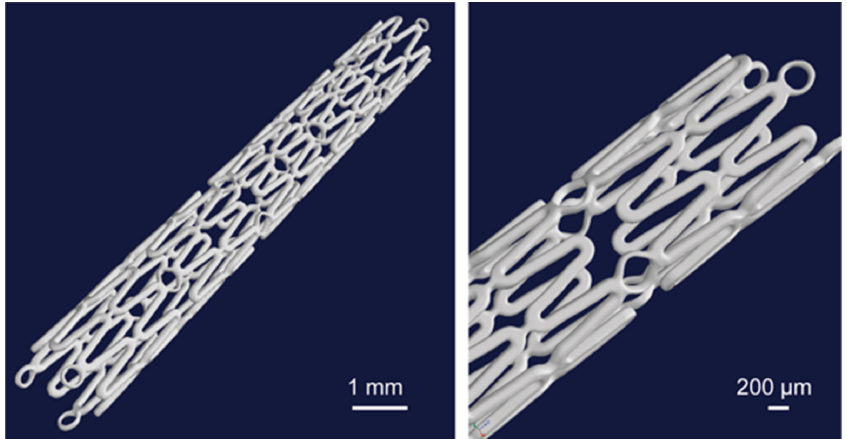
Figure 6. 3D representation of the whole stent volume from the micro-CT investigation [23].